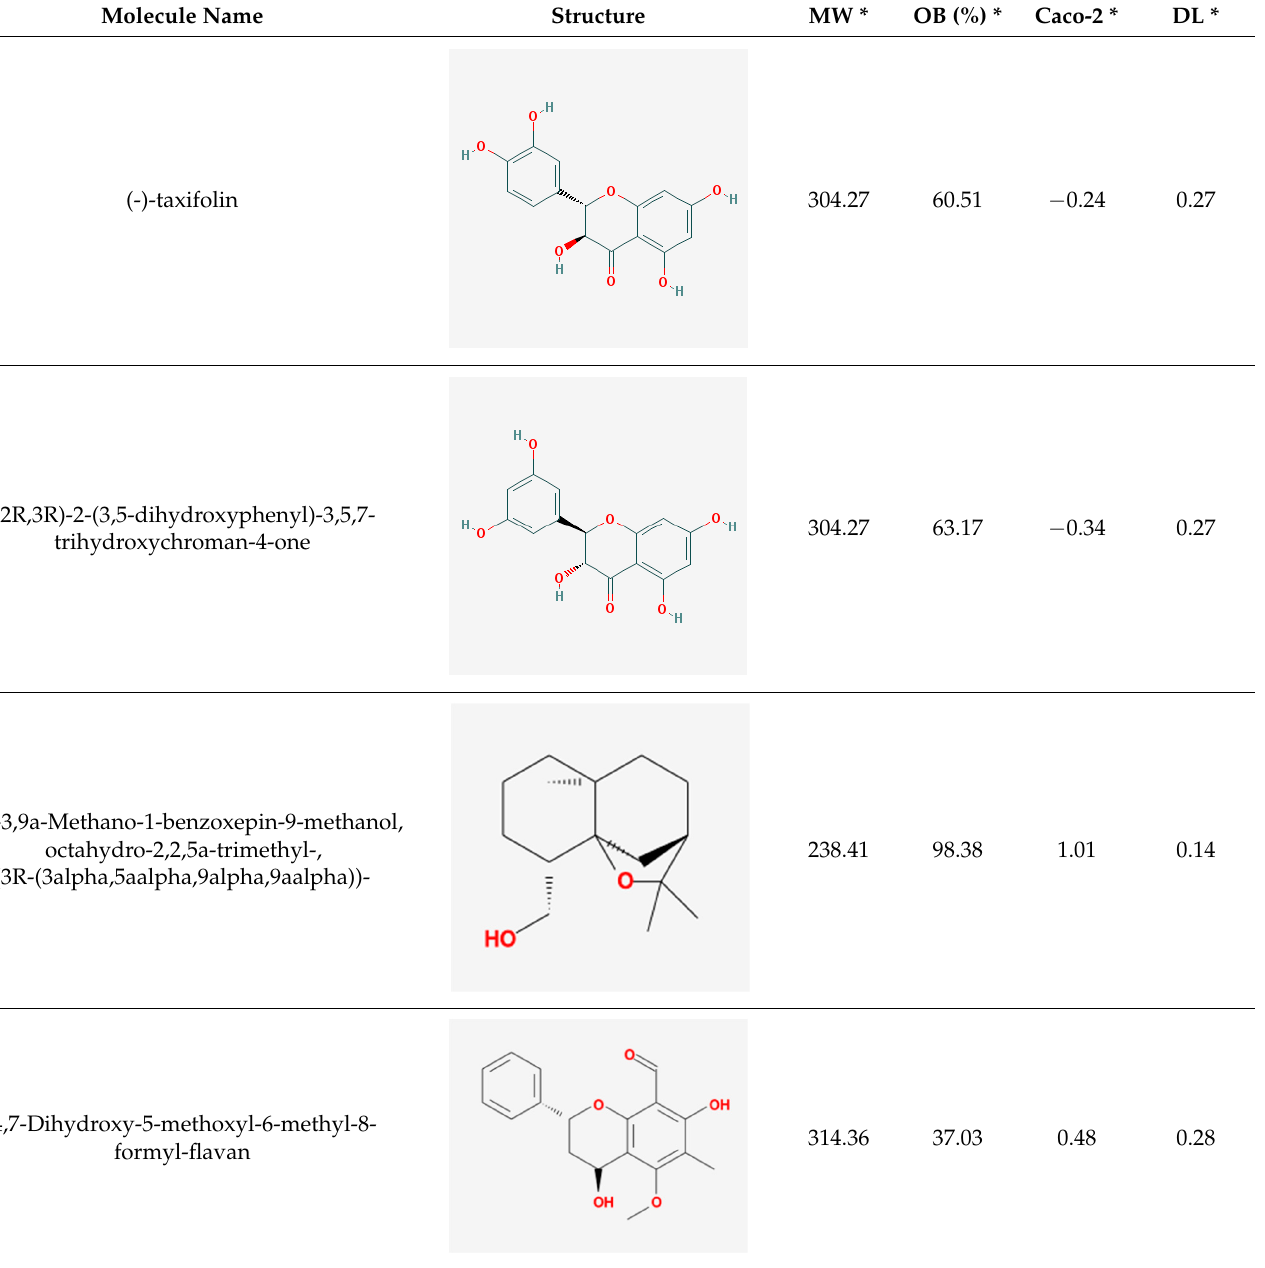
Table 1. Active compounds of Smilacis Glabrae Rhixoma .